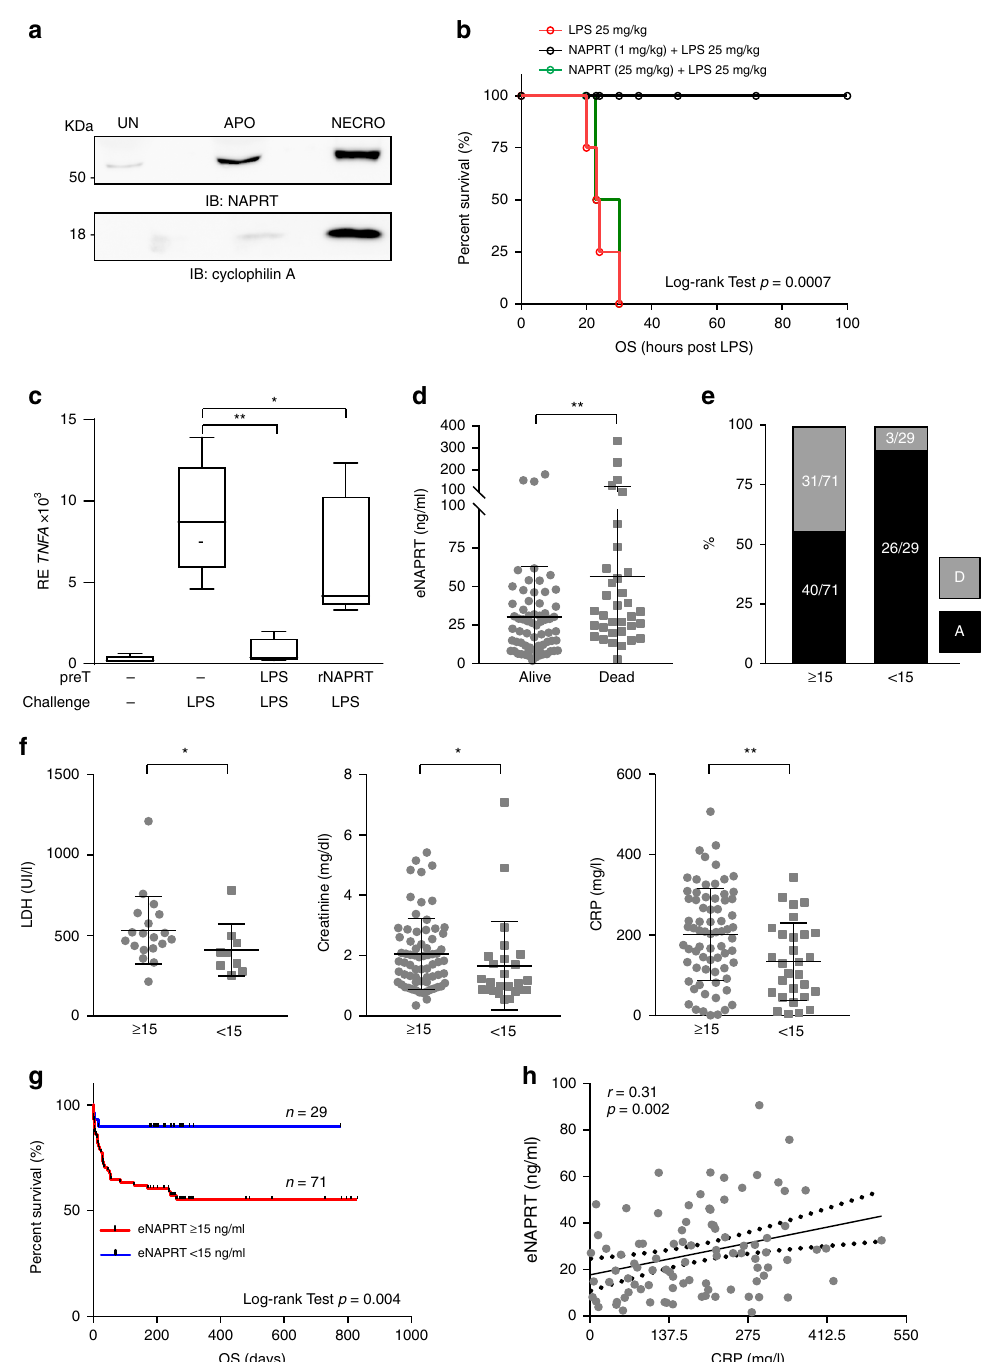
Fig. 6 eNAPRT is a risk factor for septic patients. a Western blot analysis of NAPRT in 10× concentrated HD macrophages supernatants (SN), in which apoptosis (APO) and necrosis (NECRO) were induced as described in “ Methods ” section. Detection of cyclophilin A in SN was used as positive control for necrosis induction. b Kaplan – Meier curves showing overall survival (OS) of mice treated intraperitoneally with LPS (25 mg/kg) with or without rNAPRT (1 mg/kg) or rNAPRT (25 mg/kg) 1 – 2 h prior to LPS administration. N = 6 mice/treatment group. Log-rank test shows statistical signi fi cance. c Box plots showing mRNA expression levels of TNFA evaluated by qRT-PCR in RNA from HD macrophages ( n = 5) treated as follow: 30 h of pre-conditioning (preT) with LPS 10 ng/ml or rNAPRT 10 ng/ml followed by 6 h of challenging with LPS 1 µ g /ml. Paired t -test. d Scatter dot plot showing eNAPRT levels in septic patients, according to outcome. e Graph representing the percentage of septic patients who survived (black bars) or died (gray bars) when dividing patients according to the eNAPRT cut-off of 15 ng/ml. f Scatter dot plots reporting LDH, creatinine and CRP levels in septic patients dividing according to the eNAPRT cut-off. Mann – Whitney test. g Kaplan – Meier curves showing overall survival (OS) of the cohort of 100 septic patients divided on the basis of eNAPRT levels. Log-rank test shows statistical signi fi cance. h Regression line showing a positive correlation between CRP ( x -axis) and eNAPRT ( y -axis) levels, as detected in 92 plasma from septic patients. Pearson coef fi cient ( r ) and the corresponding p -value are noted. Results are reported as box plots and dot plot, where the line in the box de fi nes the median and the error bars de fi ne the minimum and maximum or the interquartile range. Source data are provided as a Source Data fi